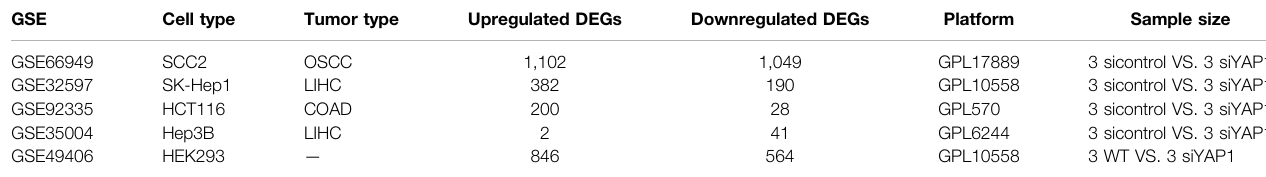
TABLE 1 | Details of the YAP1 inhibition datasets from the GEO